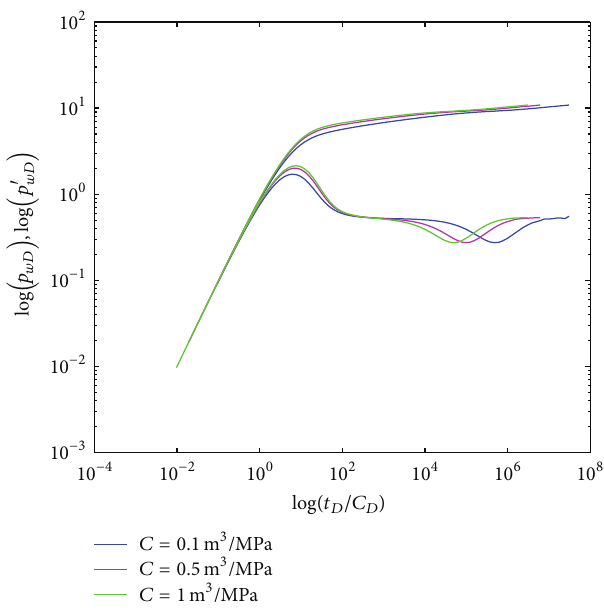
Figure 10: Effect of wellbore storage coefficient ( 𝐶 ) on type curves.